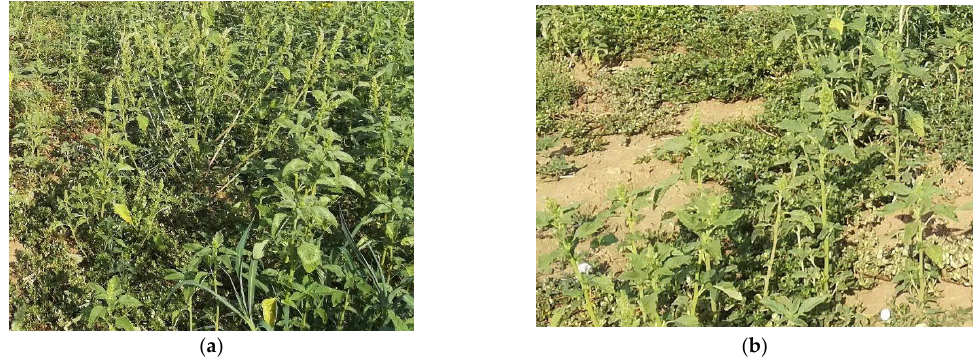
Figure 5. Weeds in the summer experimental plots at 4 WAT: ( a ) untreated control; and ( b ) pelar- gonic acid at a maximum dose (21.8 kg a.i. ha −1 , see the less susceptible weeds: P. oleracea and A. retroflexus